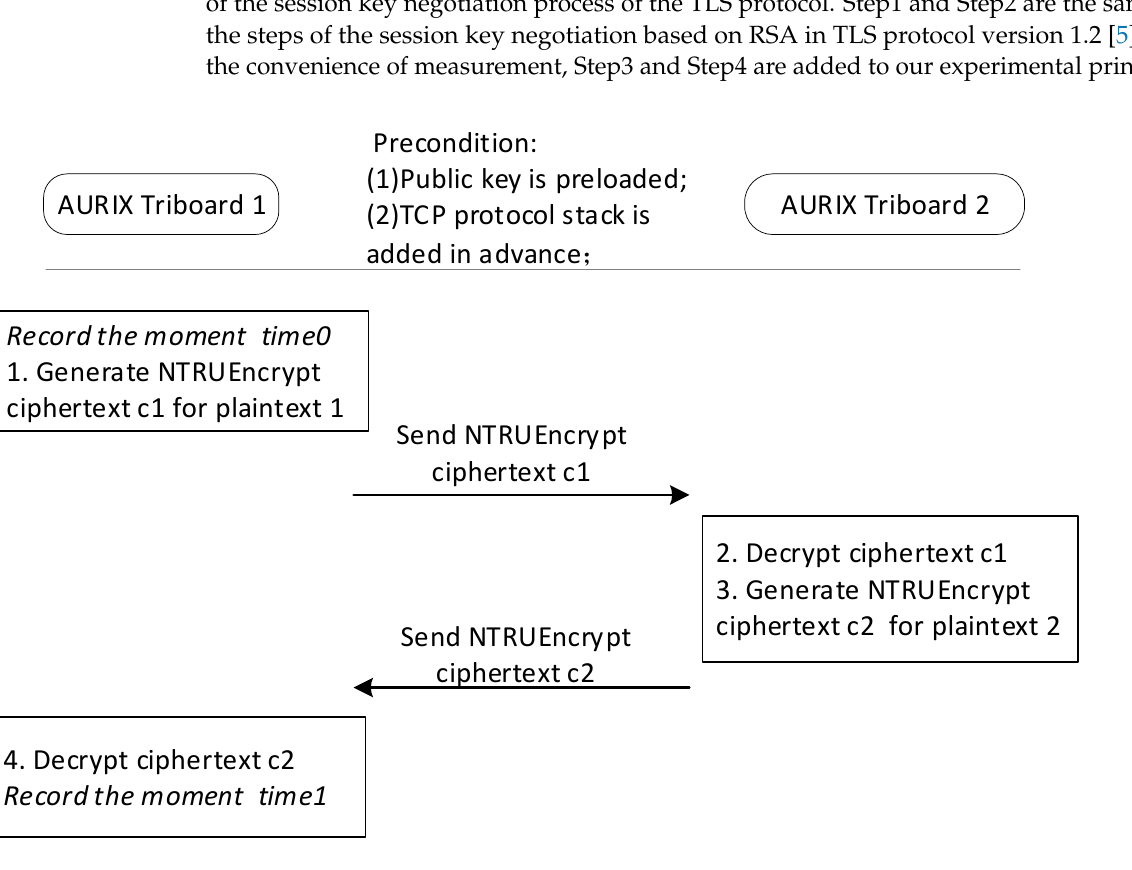
Figure 3. Principle of session key negotiation experiment based on